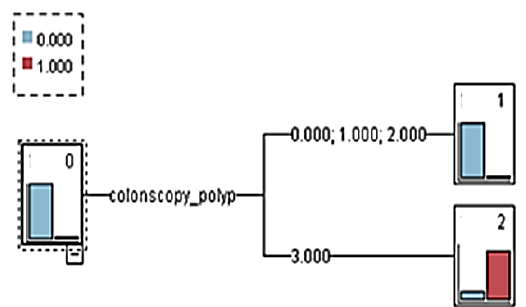
Figure 5. Decision tree model 2 (no pyogenic liver abscess variable).